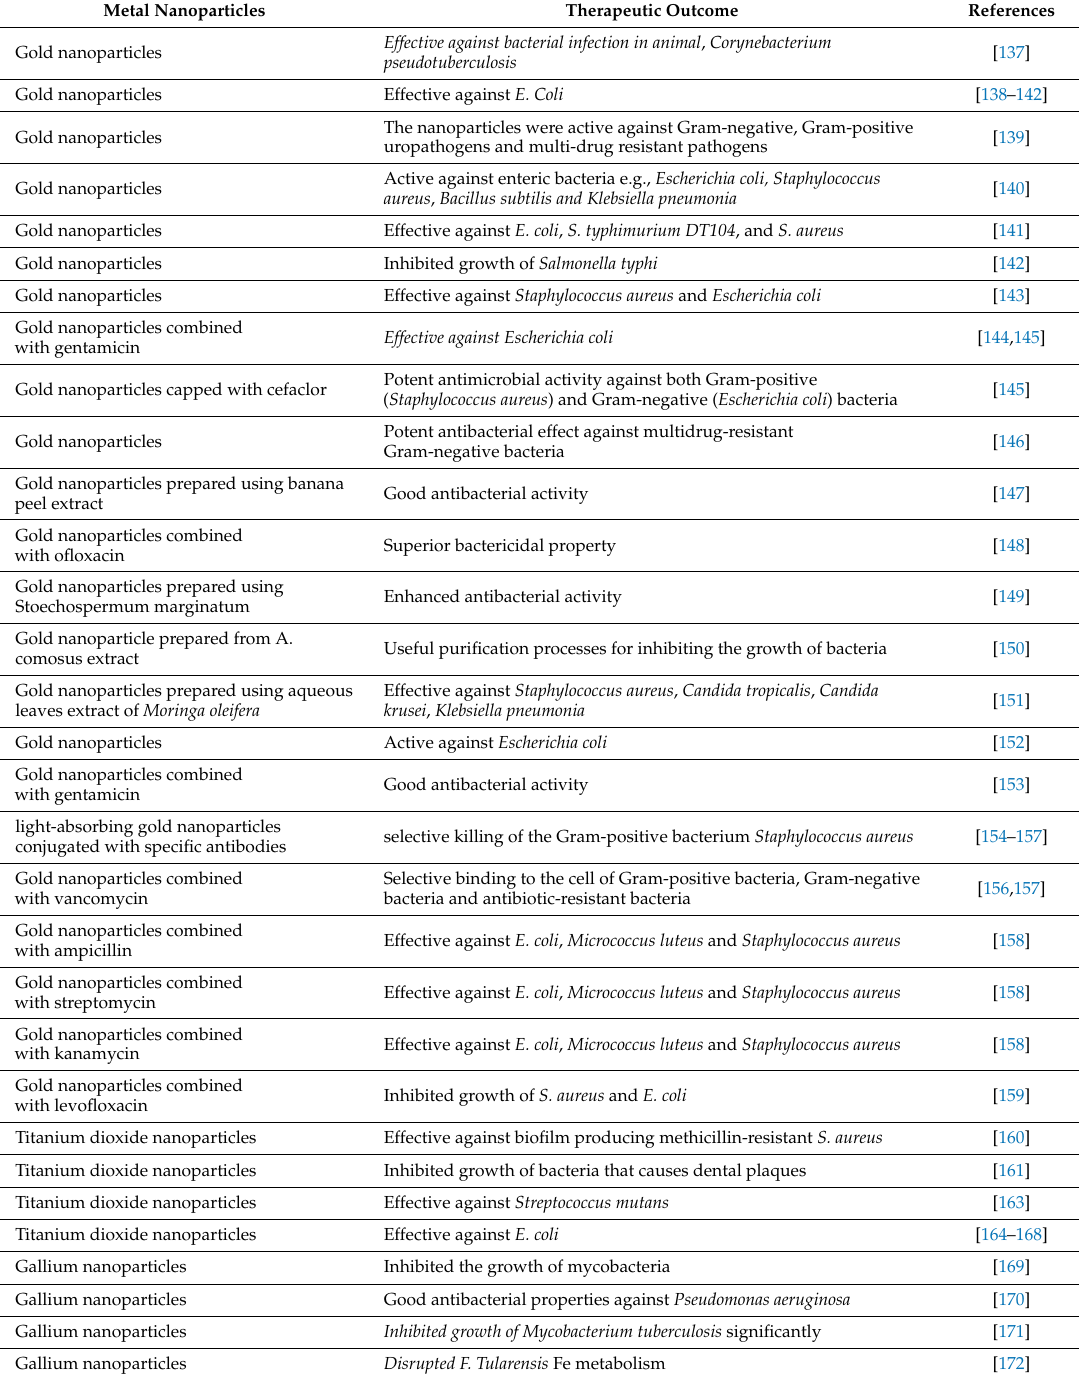
Table 4. Gold, titanium dioxide and gallium nanoparticles with antibacterial activity. Metal